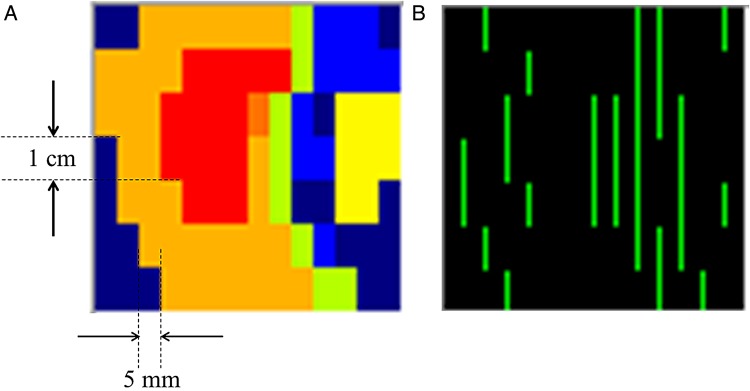
(A) Sample segmented intensity map. Red color indicates that the irradiated area had received a high intensity dose and blue color indicates that the irradiated area had received a low intensity dose. (B) MLC abutment detected image. Vertical lines in green indicate the detected MLC leaf edge.